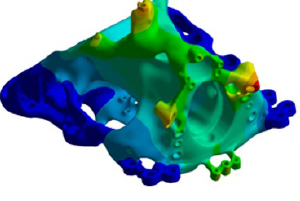
Fig. 2. Result of FEM simulation (modeshape of first eigen- frequency at 2850 Hz) of the optimized model.